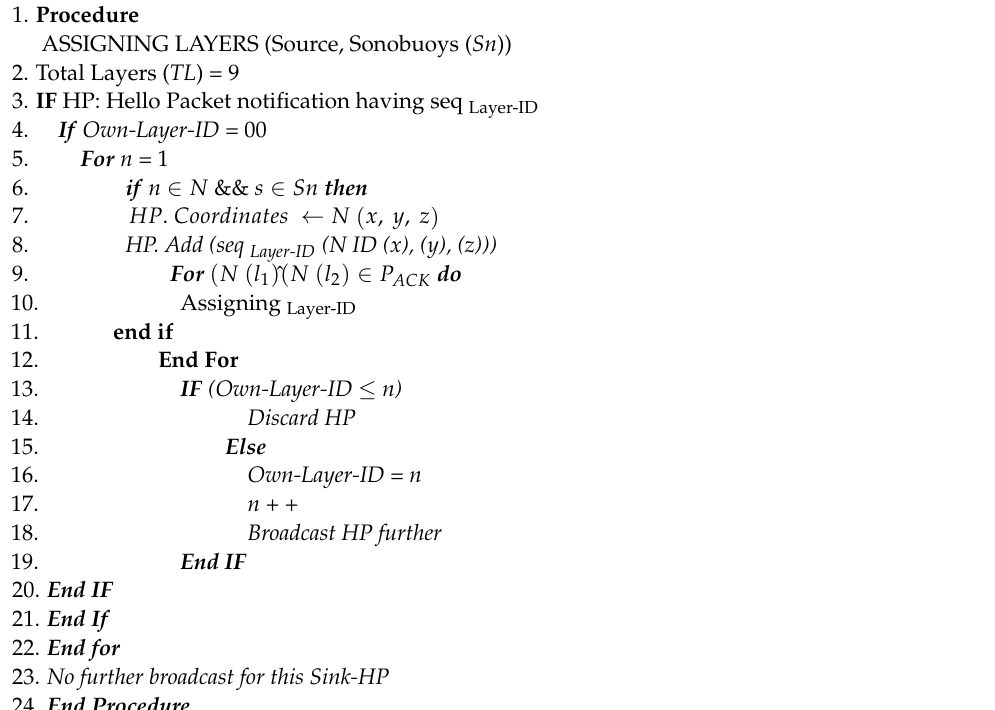
Algorithm 1: Layer-Based Adjustment of